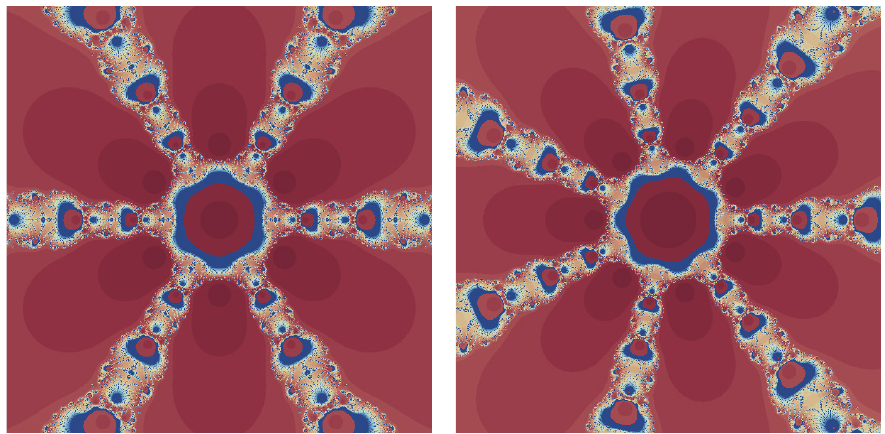
Figure 3: The fractal pictures obtained by (18) using the polynomials 𝑝(𝑧) = 𝑧 5 + 1 and 𝑝(𝑧) = 𝑧 6 + 1 .